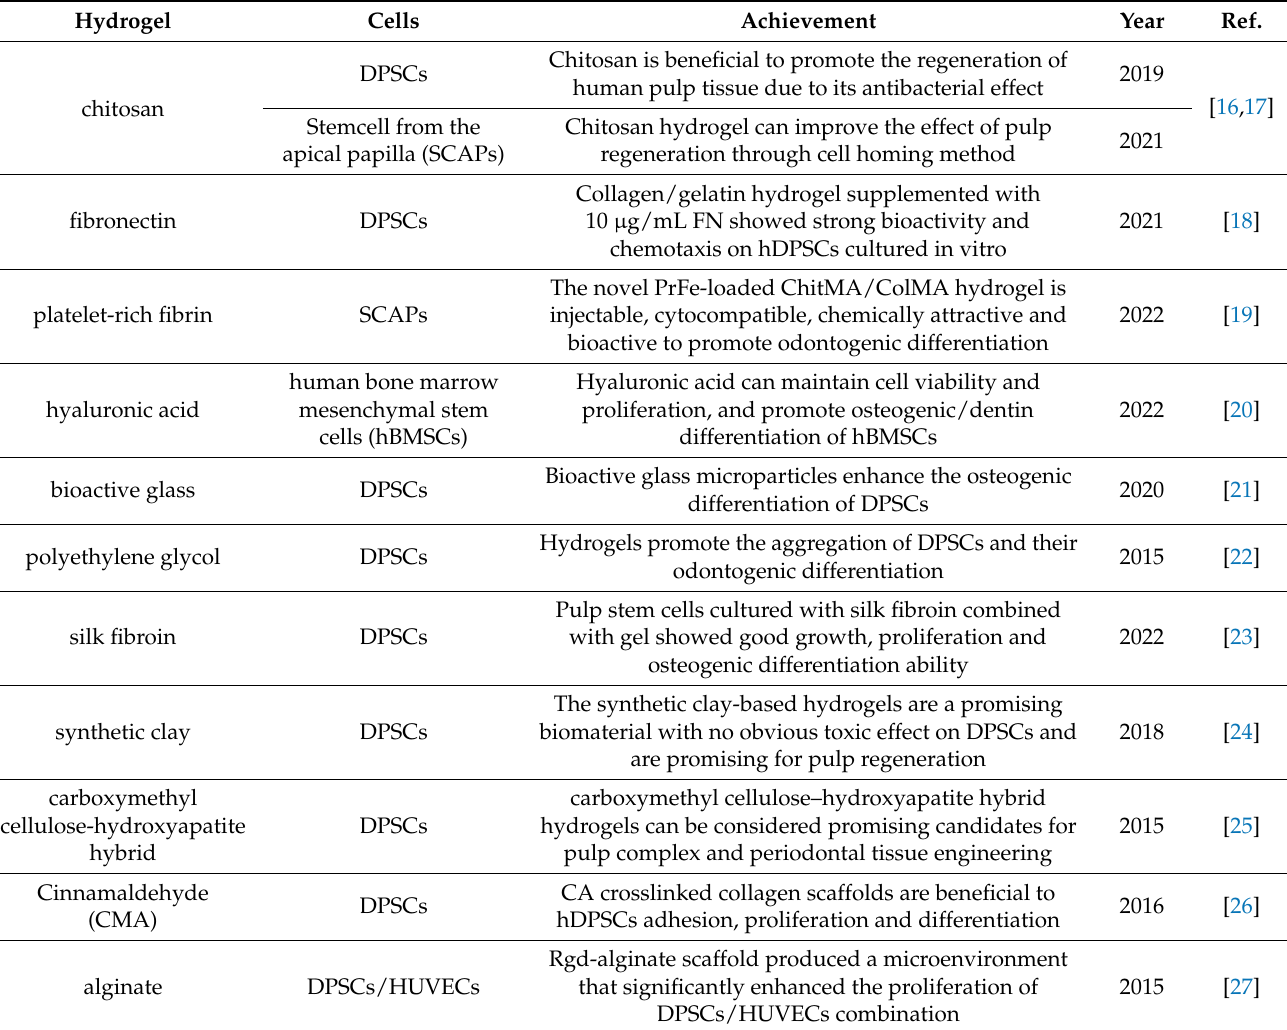
Table 1. Different types of hydrogels for dental pulp